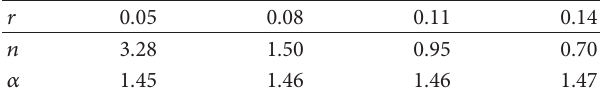
Table 1: The final results for the parameters 𝑛 and 𝛼 .